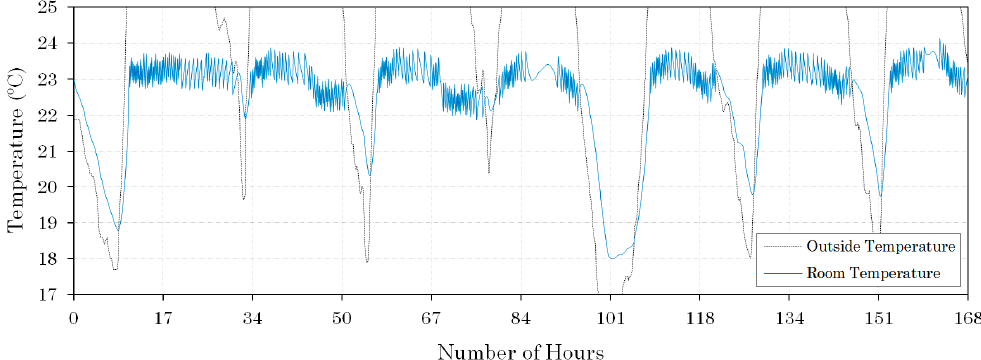
Figure 11. The temperature of the room by using MPC control option.